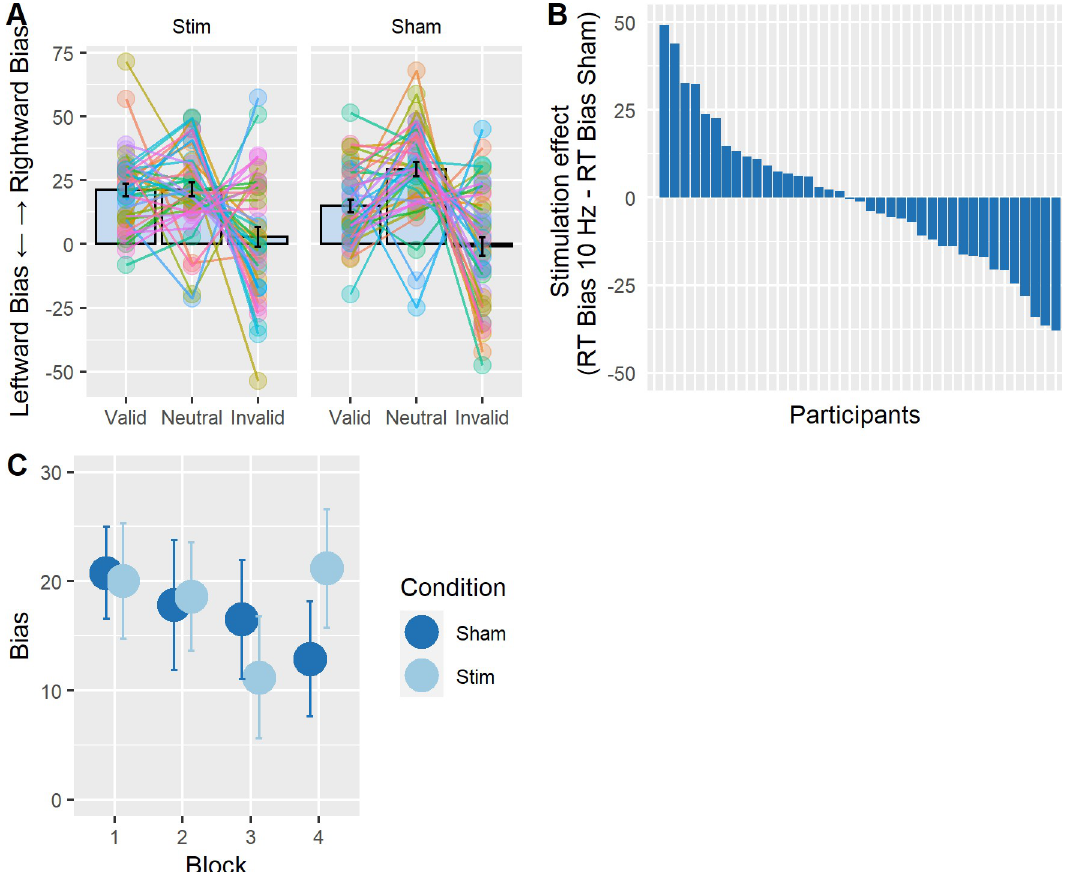
Fig 3. No tACS effects on hemifield bias A. Measure of spatial bias across simulation and validity conditions (RT Left hemifield − RT Right hemifield ). A positive value indicates a rightward bias (i.e. faster RTs in the right hemifield), whereas a negative value indicates a leftward bias (i.e. faster RTs in the left hemifield). The average values for each condition are superimposed with individual data points of each participant. Error bars represent 95% confidence interval corrected for a within subjects design [46]. B. Stimulation effect per participant on spatial bias (RTBias 10Hz tACS − RTBias sham ). A negative value means that participants had a greater leftward (more negative) spatial bias with 10 Hz stimulation as compared to sham (expected direction). C. Change in the measure of spatial bias across the 4 experimental blocks (~5 min). The plot displays the average spatial bias per block and the lines represent the standard error, where a positive value of bias indicates a rightward bias. There was no significant difference between the stimulation conditions with time-on-task.